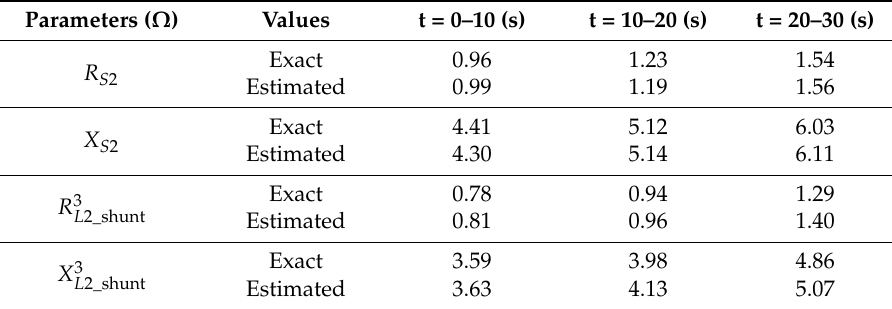
Table 4. Results for the negative sequence impedance.